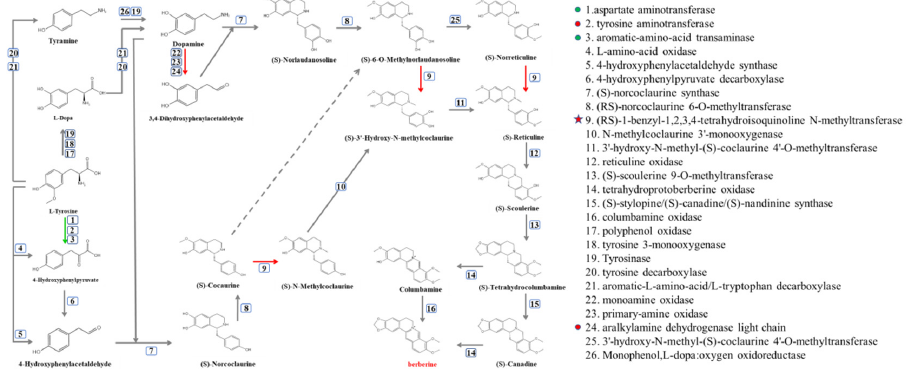
Figure 5. Synthetic pathway of BBR. Green arrows represent the presence of the enzyme in bacteria with increased bacterial content and bacteria isolated from soil water. The red arrow indicates that the enzyme is only present in bacteria with increased bacterial content.